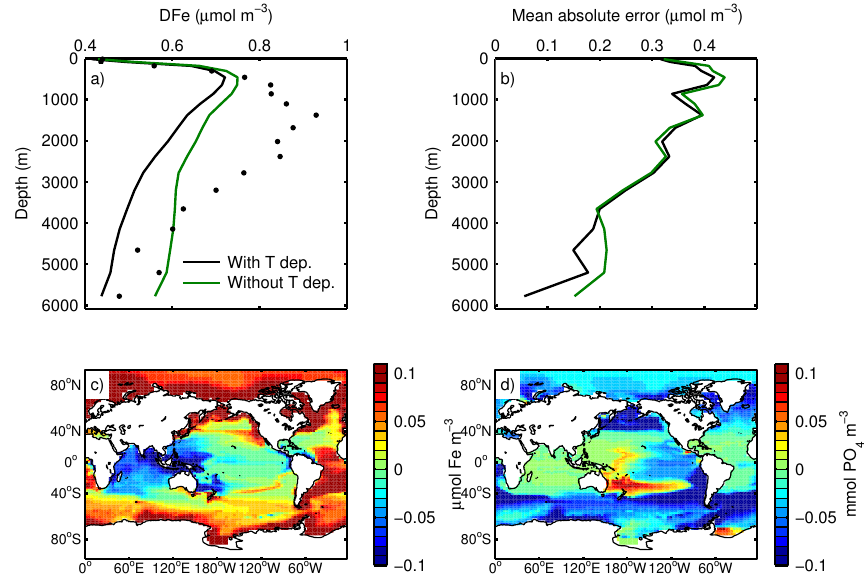
Figure 20. Influence of the temperature dependence ( T dep.) of the benthic iron release. (a) Vertical profiles of globally averaged dissolved iron concentrations (DFe) with (black) and without (green) the temperature dependence. (b) Vertical profile of the averaged absolute deviation between simulated and observed DFe with (black) and without (green) the temperature dependence. (c) Difference in surface dissolved iron concentrations and (d) difference in surface phosphate concentrations between the simulations without and with the temperature